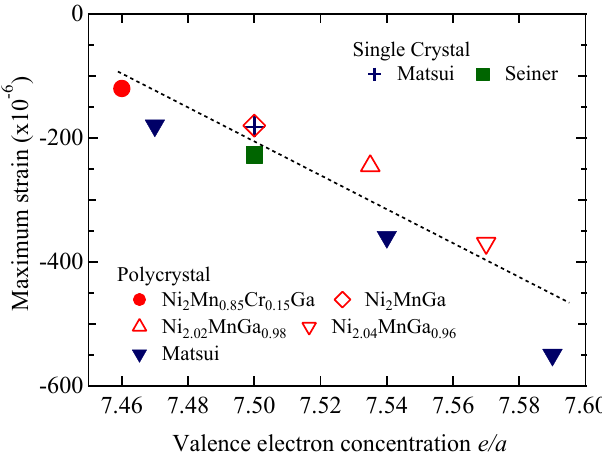
Figure 8. The temperature dependencies of the magnetostriction for ( a ) x = 0.02 and ( b ) x = 0.04.